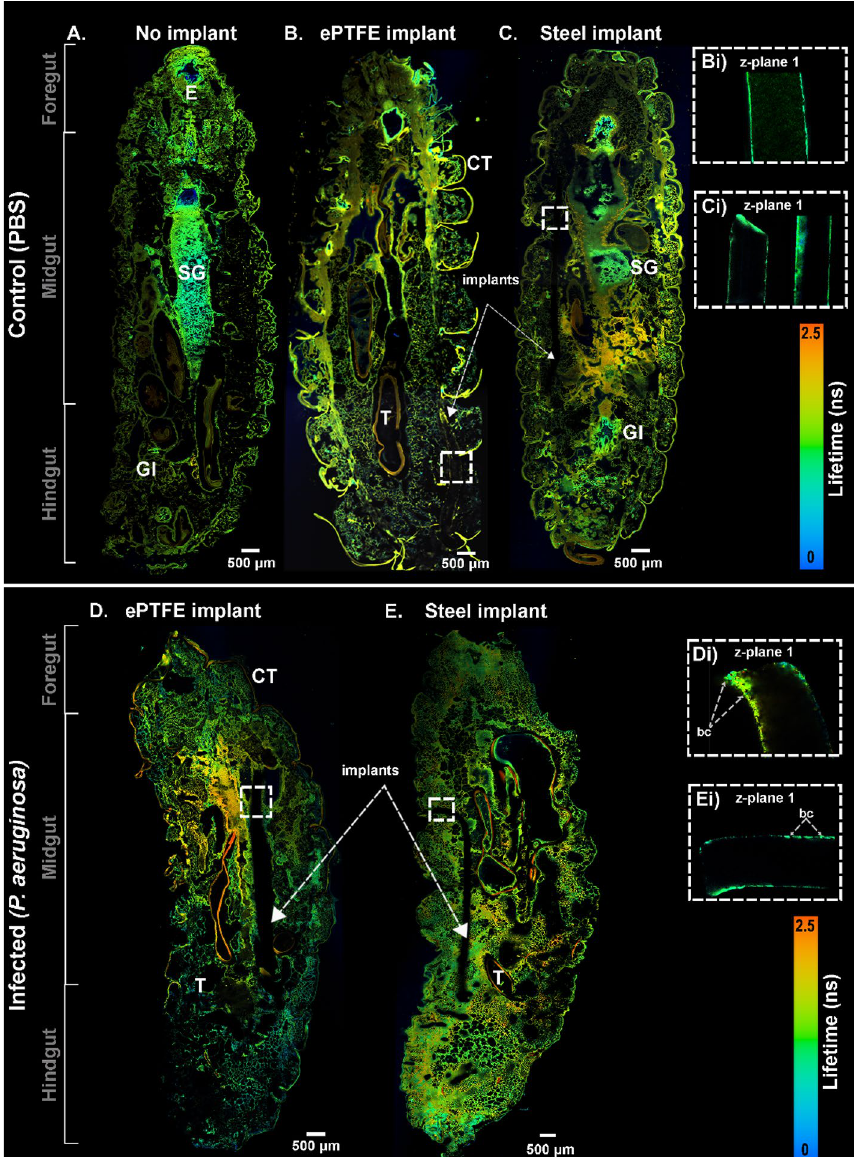
Figure 6. A FLIM image showing the sagittal section of the G. mellonella larval body displaying the entire larvae of control without an implant ( A ), with PBS-incubated ePTFE ( B ) and stainless steel ( C ) implants. G. mellonella larvae with P. aeruginosa (PA01)-infected ePTFE ( D ) and stainless steel ( E ) implants. The differing lifetime information from endogenous fluorophores such as flavins and lipo-pigments is presented as false- color images ranging from blue to red (scale 0–2.5 ns). The squared insets with white dashed lines in ( B–E ) were zoomed to visualize the plastic implant at a different focal depth (z-plane 1) in ( Bi , Di ) and the stainless- steel implant in ( Ci , Ei ), respectively. CT = cuticle, T = trachea, GI = gastrointestinal tract, SG = silk gland, E = esophagus, bc = bacterial